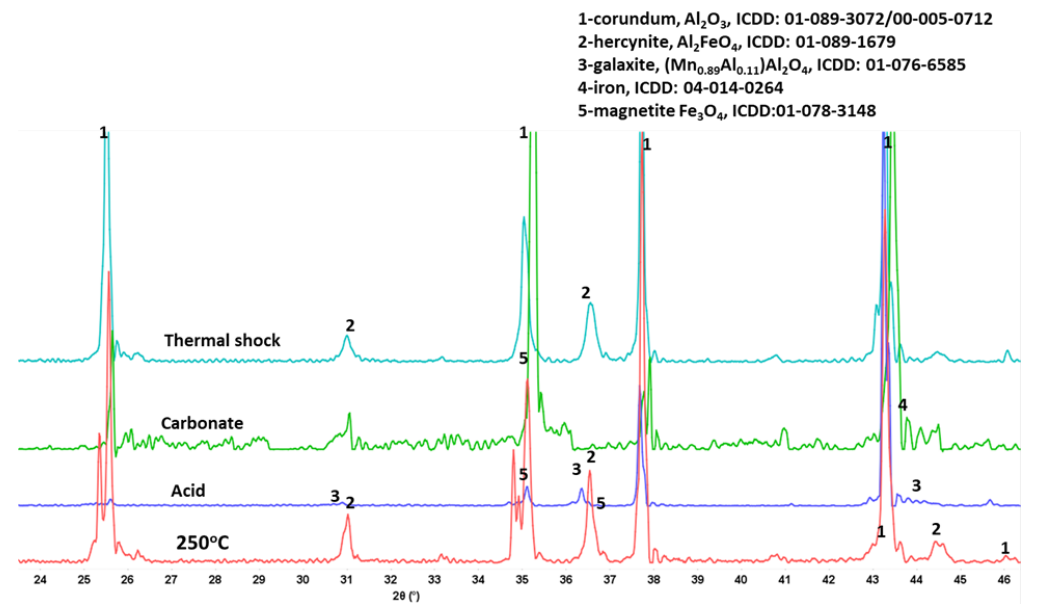
Figure 27. XRD patterns of aluminum oxide samples after the autoclaving at 250 °C, acid-, alkaline carbonate-, and thermal shock tests.